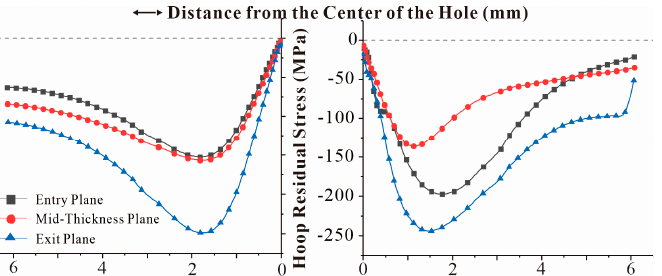
Figure 20. Residual stress distribution in the right hole radial direction for a three-hole specimen with triple aperture spacing (SSCE from left to right).